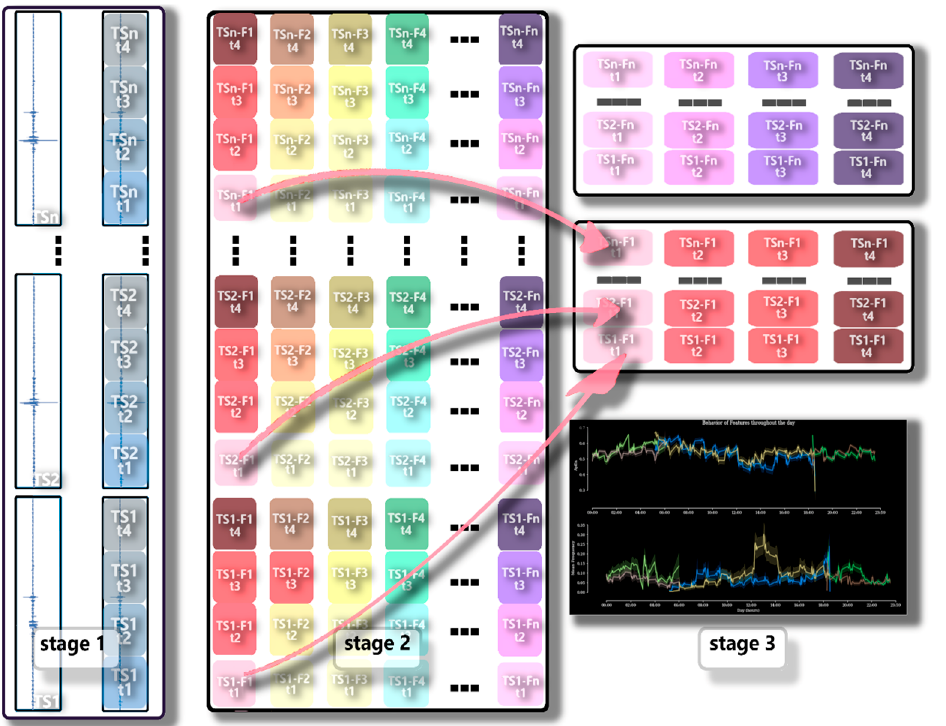
Figure 11. TDAF schematic. In stage 1, we have the time series (TS1, TS2, ..., TSn) and the process of dividing and storing the position information referring to the time of each cut (t1, t2, t3, t4). In stage 2, the characteristics (F1, F2, F4, ..., Fn) are calculated for each slice and together with the result, the timing information is virtually saved. In stage 3, time information is used for each generation and bin placement (data grouping). With each bin in place, the original time series is reconstructed, now with the results of each analyzed feature.